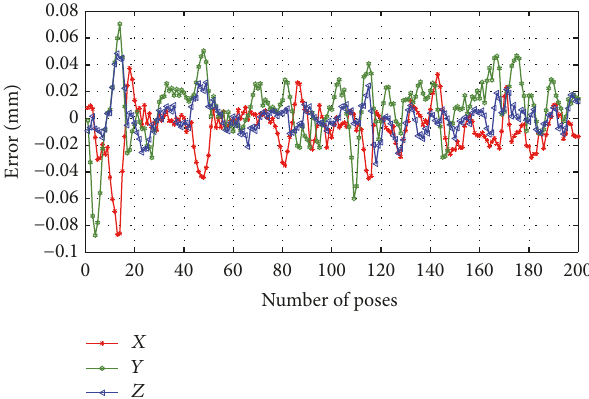
Figure 8: Prediction error of the BPNN model for the AACMM.